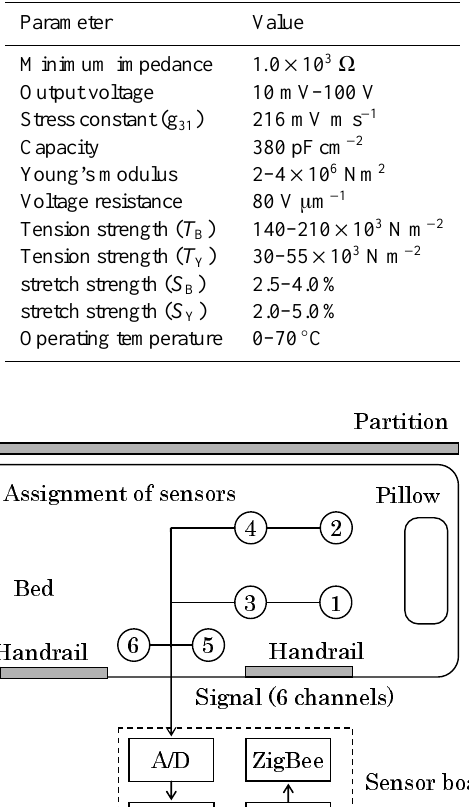
Table 2. Specifications of Piezoelectric film DT2-028K / L (Mea- surement Specialties Inc.).